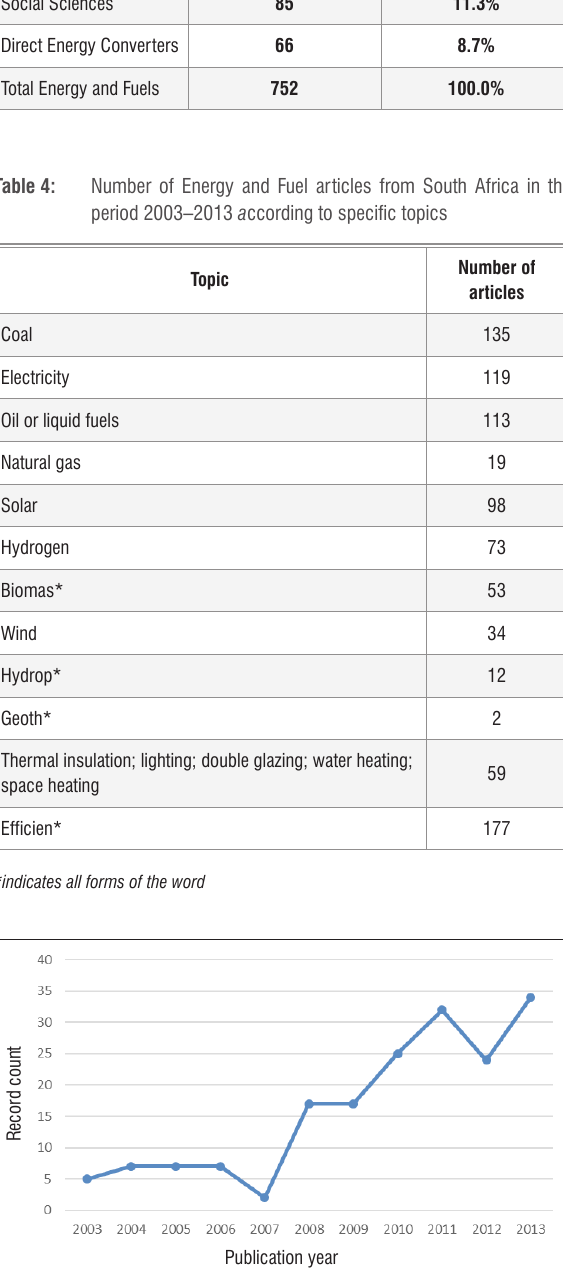
Figure 4: Growth in the number of Energy and Fuels articles related to efficiency from South Africa in the period 2003–2013. Table 5 shows the South African organisations that are producing the majority of core energy and fuels literature. The Universities of Cape Town, Stellenbosch and Pretoria are on top of the list. Three divisions of Sasol also appear on the list. It should be noted that even the top institutions in the country produce less than 10 articles per year each on average during the period. The small number of publications makes